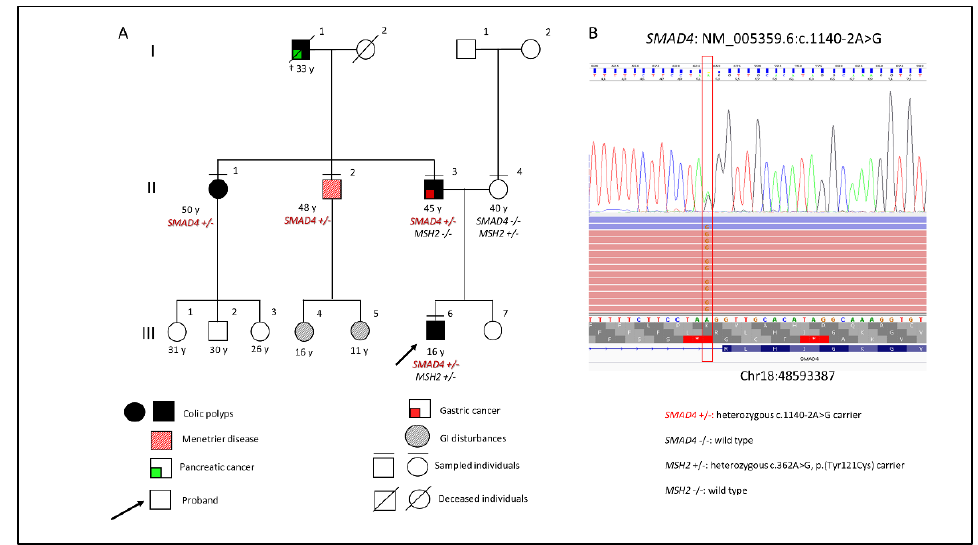
Figure 1. ( A ) Pedigree of the family showing phenotypes of affected relatives and genotypes of sampled individuals. Male is represented by a square; female is represented by a circle. GI, gastroin- testinal. ( B ) Multi-gene panel analysis. NGS and Sanger sequencing of the proband showing the intronic heterozygous c.1140-2A>G substitution in SMAD4 gene on genomic DNA. The identified pathogenic variant in the SMAD4 gene is visualized by Integrative Genome Viewer (IGV) software. Ref Seq (Reference sequencing) used for variants annotation: NM_005359.6.